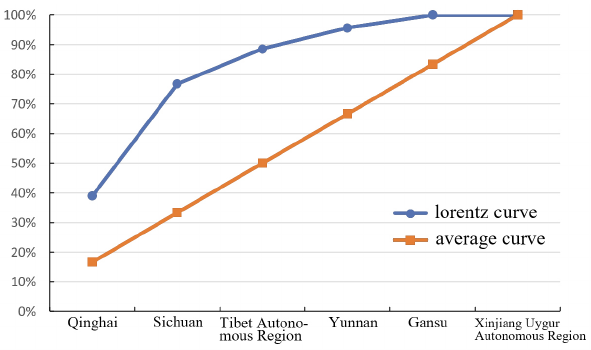
Figure 5. The Lorentz curve. Table 3. Distribution of traditional villages in provinces on the Tibetan Plateau.